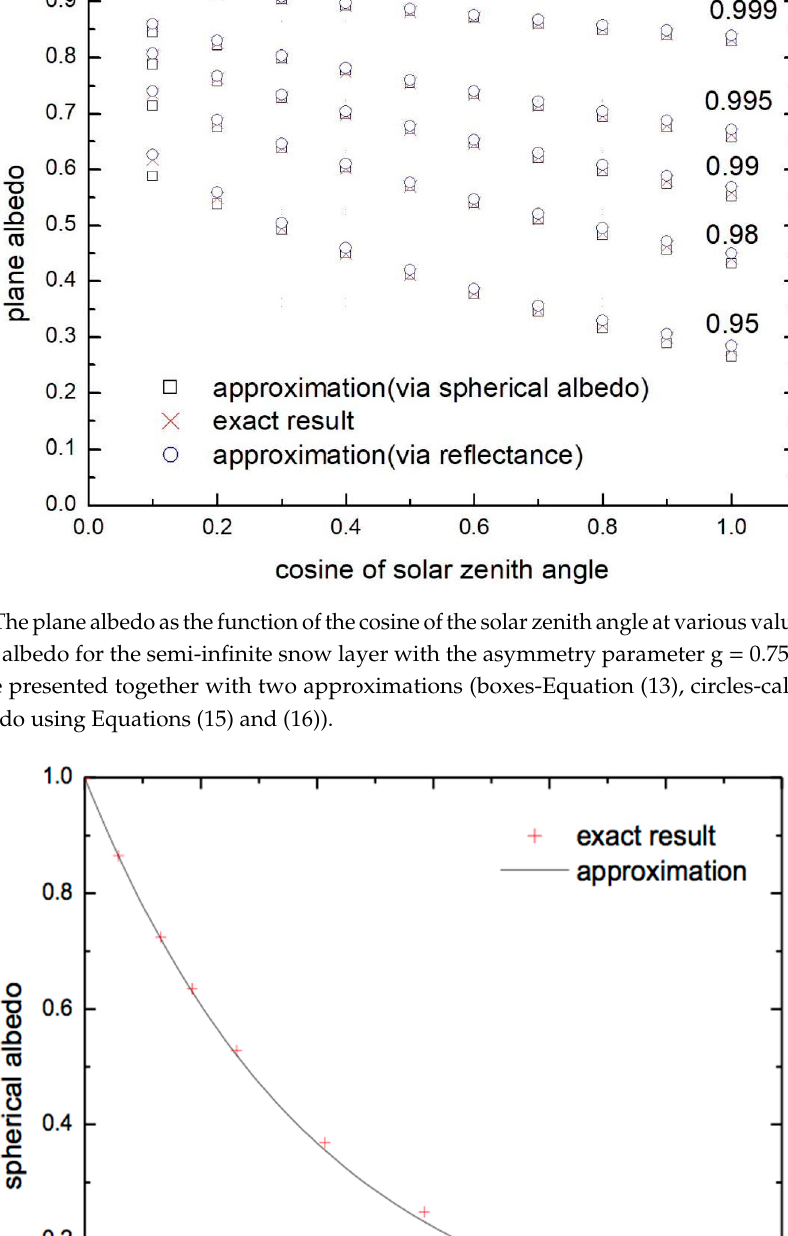
Figure 2. The dependence of the snow reflectance calculated using Henyey-Greenstein phase function at g = 0.75 (semi-infinite snow case) and various values of single scattering albedo (SSA) as a function of the solar zenith angle at the nadir observation (exact results: crosses, approximation: boxes).